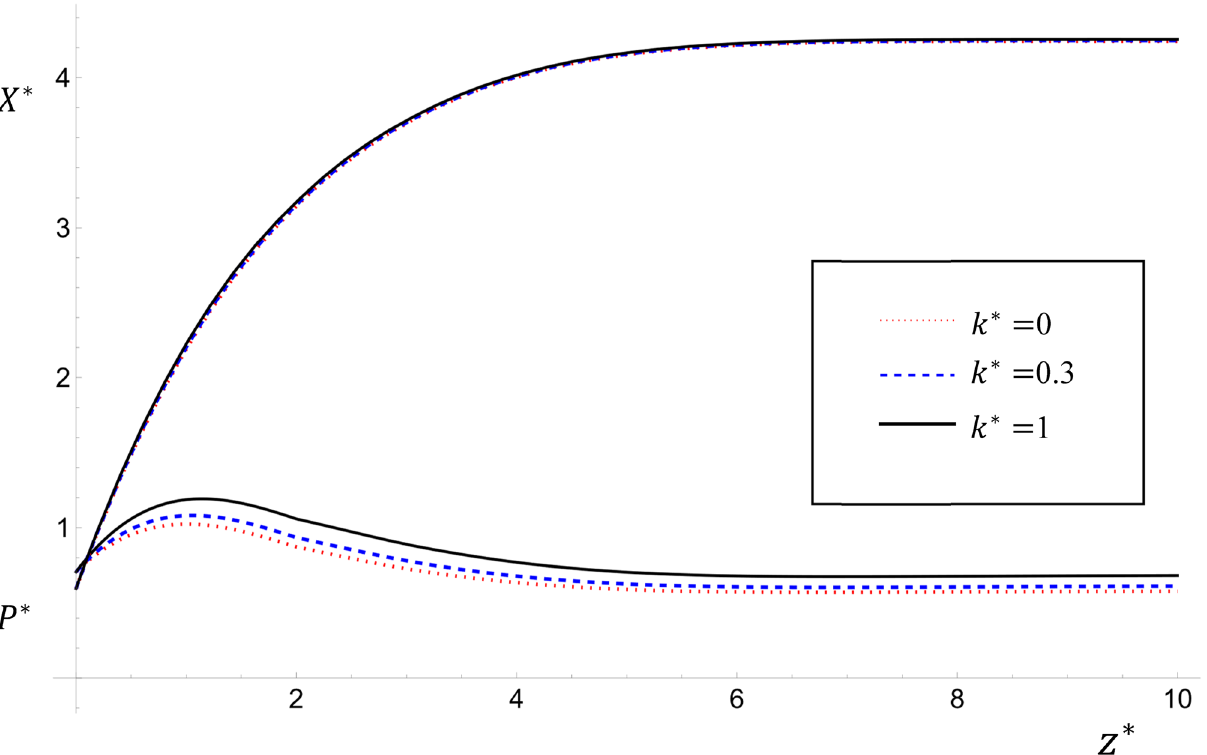
1.6 , Pe P ∗ = Pe X ∗ = U ∗ ∗ =